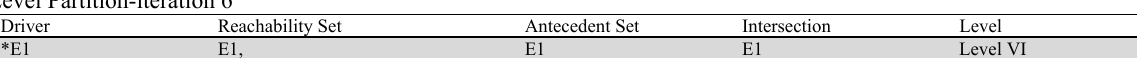
Level Partition-iteration 6